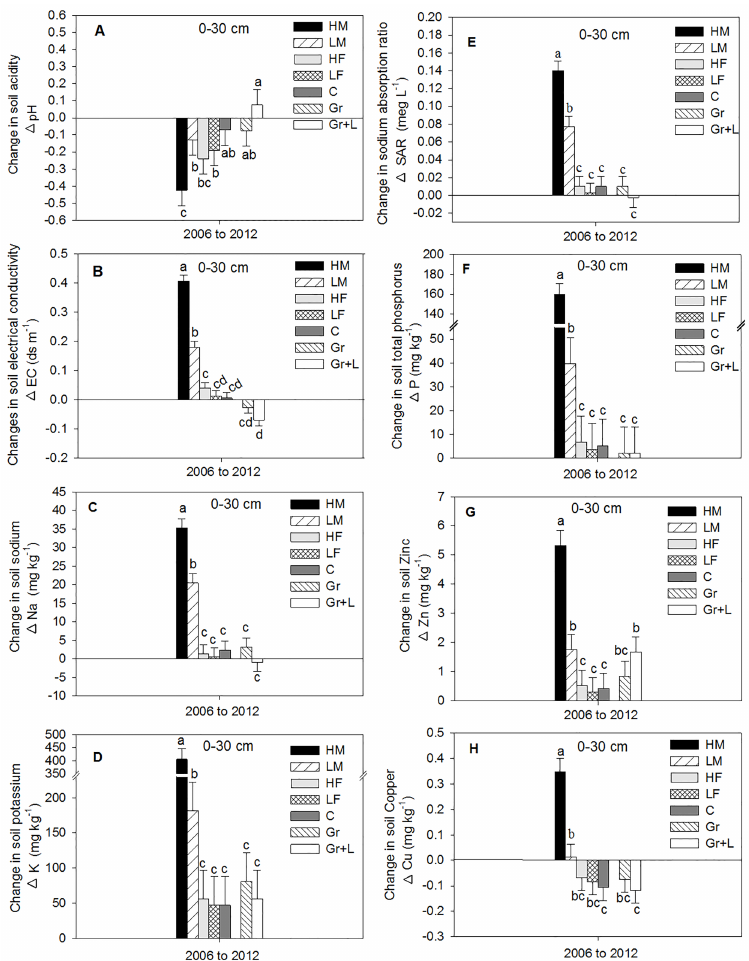
Fig 3. Change in soil chemical properties (A-H) from 2006to 2012 at 0–30 cm depth averagedacross tillage treatmentsas influenced by different N and grass legume mixtures treatments. HM treatment represents beef manureadditionat three times the recommended N (high) rate; LM treatment represents beef manureadditionat the recommended (low) rate; HF treatment represents chemical fertilizer (urea) additionat doublethe recommended N (high) rate; LF treatment represents inorganicfertilizer (urea) additionat the recommended (low) rate; C treatment represents no nitrogenaddition(control); Gr represents the native grass; and Gr +L represents the mixture of native grass and legume.The error bars represent standarderrors of the mean. The different lowercaseletters represent significantdifferences amongN treatments (P < 0.05).